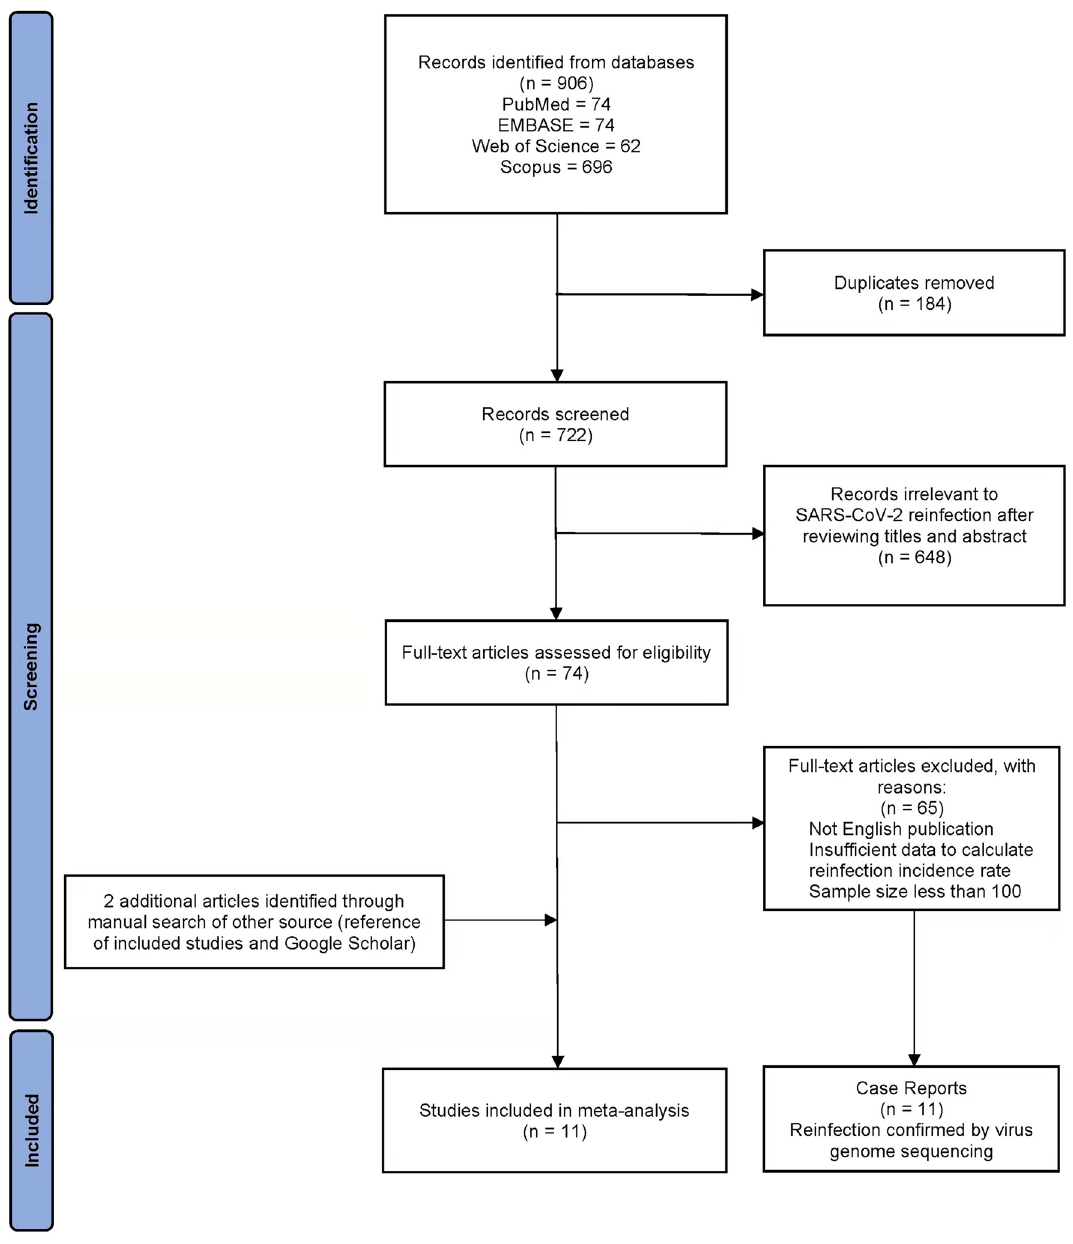
Figure 1. Flow diagram of literature search and study